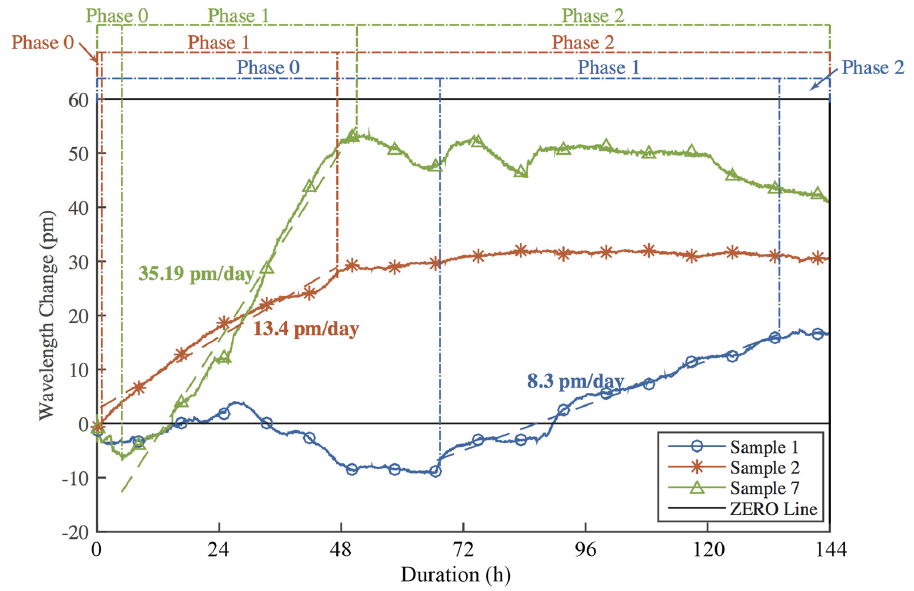
Figure 19. Bragg wavelength change vs. time of Samples #1, #2, and #7 for data analysis. Detail observations of each phase identified by the embedded FBG sensors on the three samples